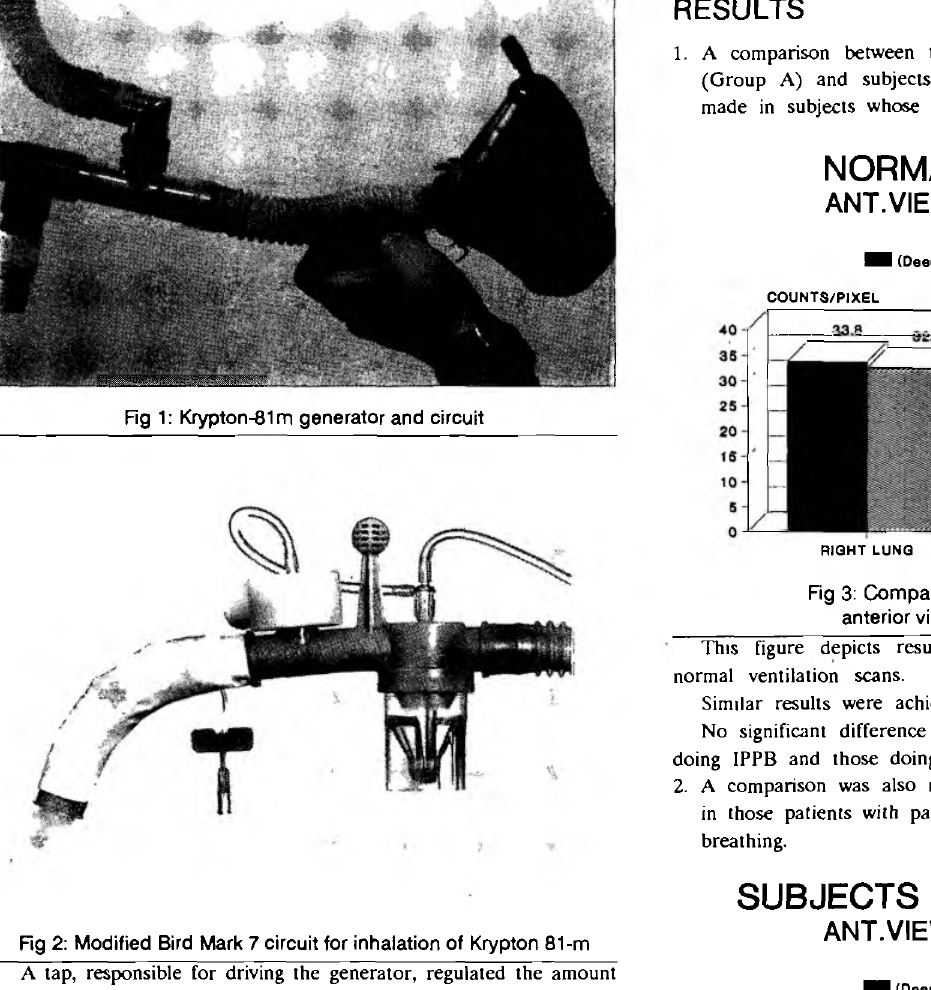
Fig 2: Modified Bird Mark 7 circuit for inhalation of Krypton 81-m